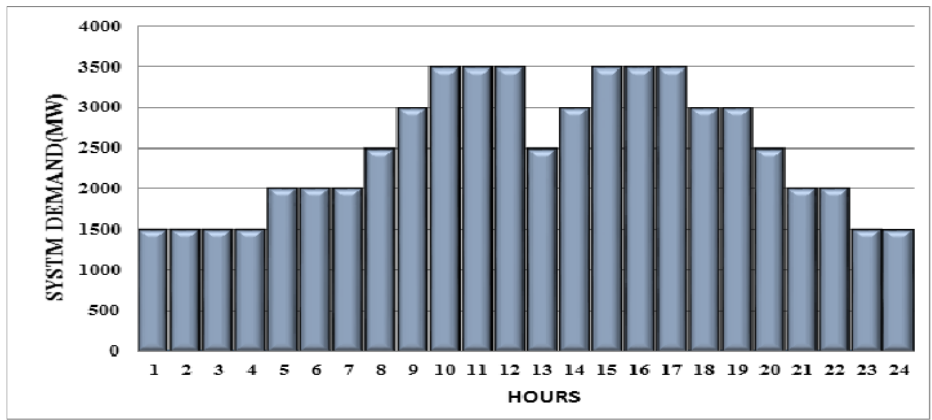
Figure 9. Power Load Forecast by the System Operator. Table 8. Data Of Genco-K Power Blocks.